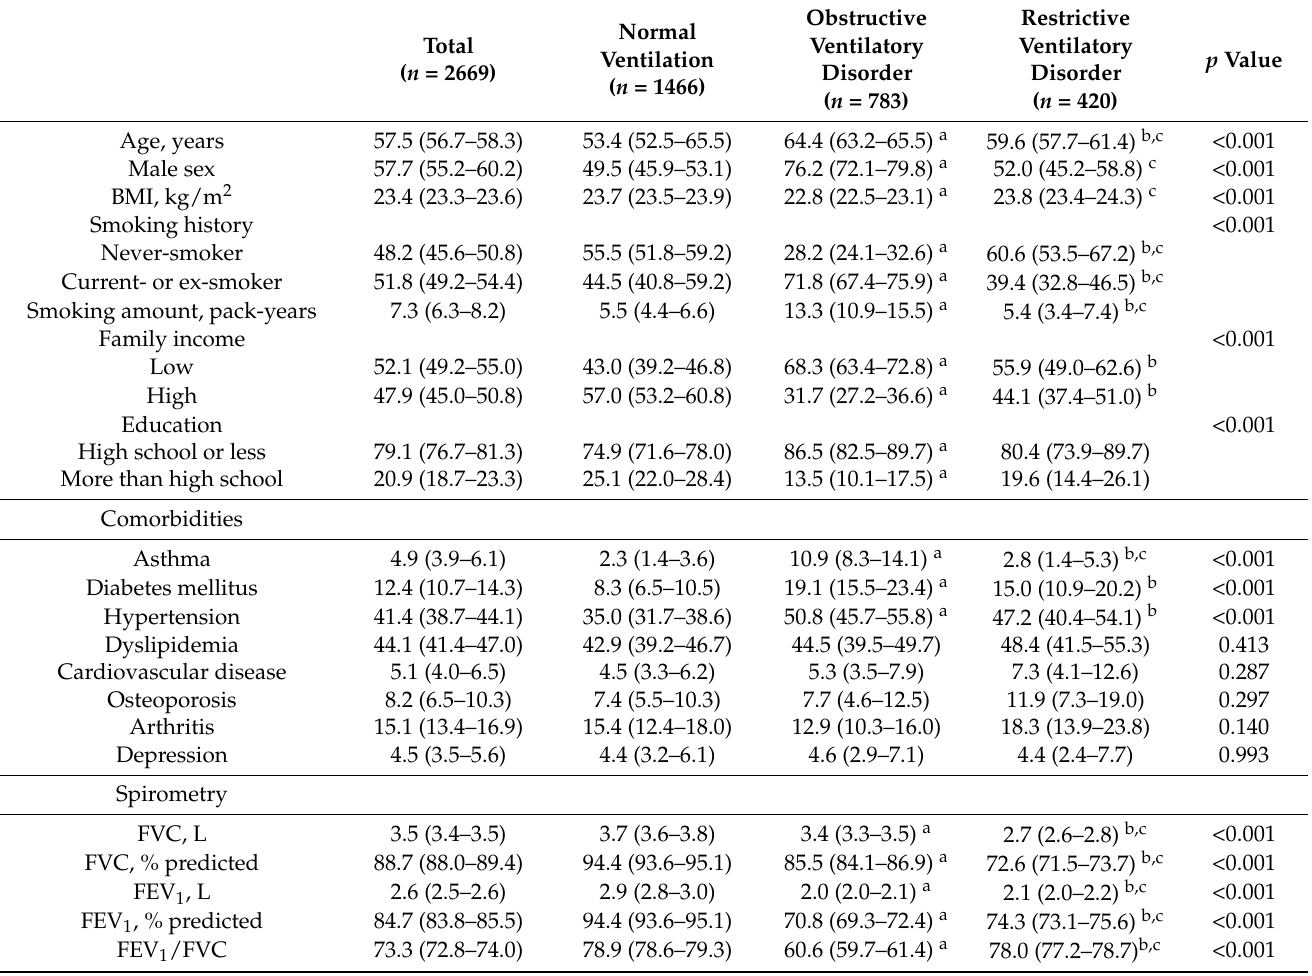
Table 1. Baseline characteristics of subjects with prior TB by spirometric